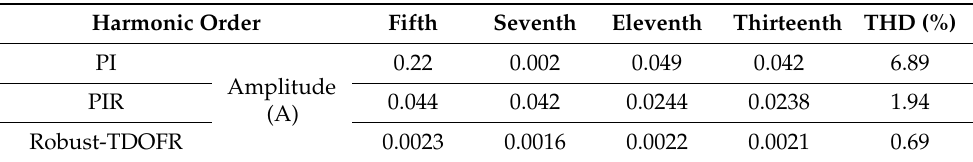
Table 3. Simulation results under the operation of no-load.